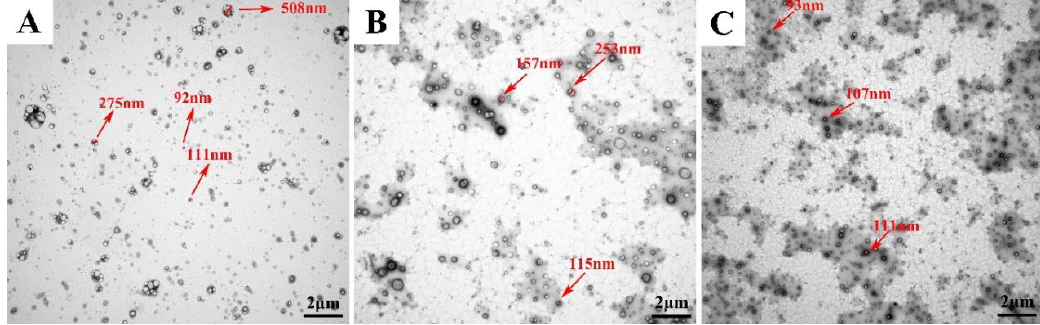
Figure 8. Changes in lyophilized deformable nanovesicles after storage at 25 °C for a period of 6 months. ( A ) 8%-T, ( B ) 8%-L, and ( C ) 8%-L-T.